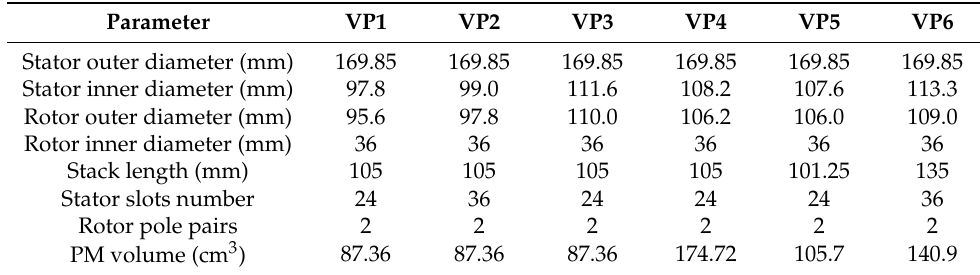
Table 5. Optimized geometrical parameters.